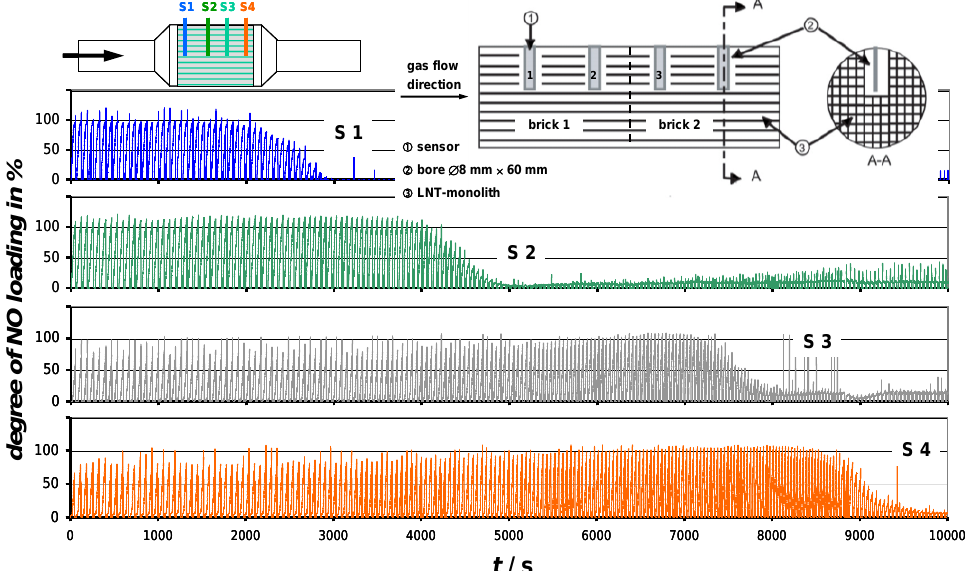
Figure 4. Engine dynamometer test of four sensors representing the status of the LNT coating along the flow axis as indicated. SO is added to speed up sulfurization. Please 2 note: the increasing spike frequency is a result of the increased regeneration frequency initiated by the engine control to compensate the decreasing NO storage capability due to x sulfur poisoning. From [20] and [21]. Reprinted with permission from SAE paper 2008-01- 0447 © 2008 SAE International.